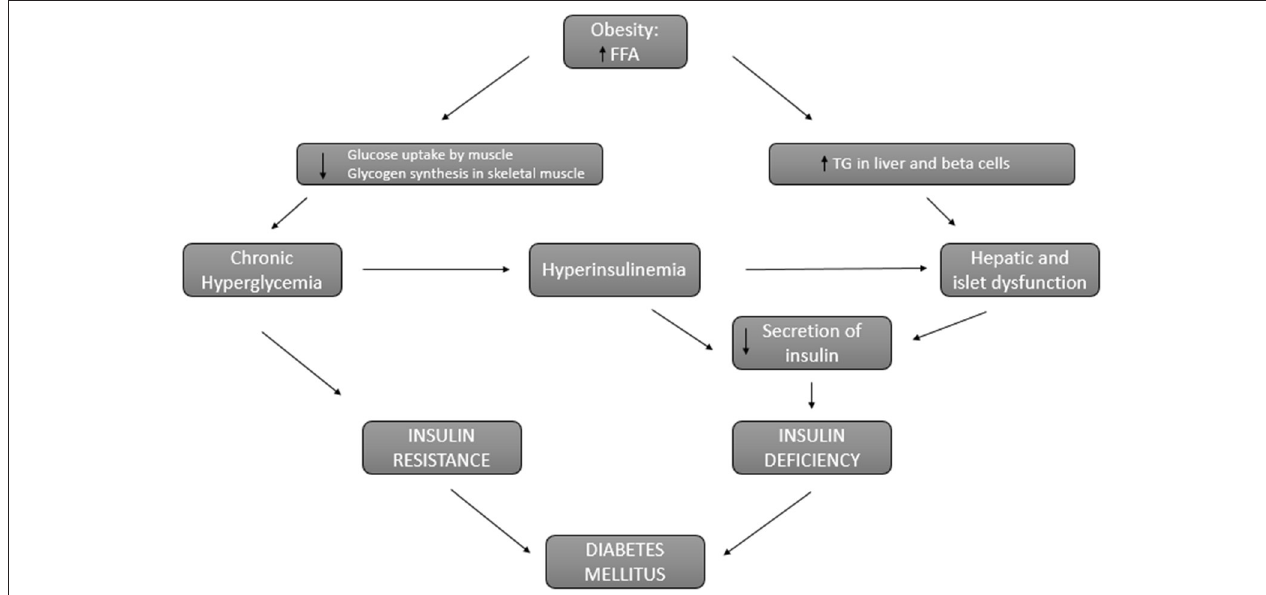
FIGURE 2 | Connection between obesity and diabetes. Pathways involved in insulin resistance and insulin deficiency that lead to diabetes in obese patients. FFA, free fatty acids; TG,